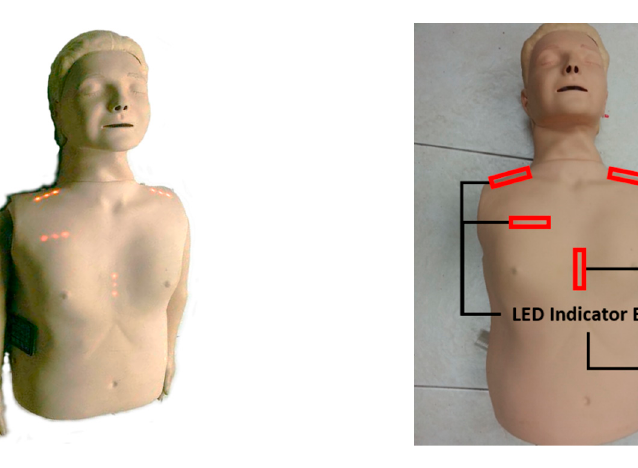
Figure 17. The LED indicator bars for CPR.